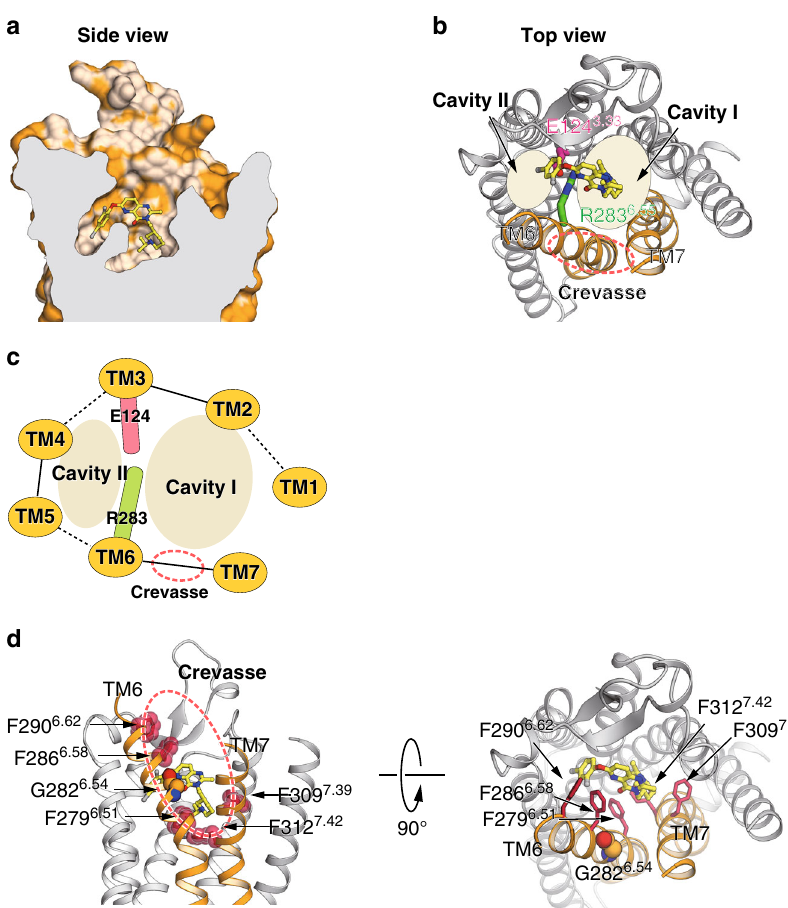
Fig. 2 Bifurcated ligand-binding pocket in the ghrelin receptor, and the structure of the gap. a The cutaway surface for the ghrelin receptor in complex with the antagonist Compound 21 reveals a bifurcated ligand-binding pocket. b The ligand-binding pocket of the ghrelin receptor. c Schematic model of Fig. 2b. d The phenylalanine cluster forms a crevasse in the ghrelin receptor. The fi ve phenylalanines are shown as sticks in dark orange. The crevasse is shown as a red dashed line. G282 is shown as spheres with carbon atoms in orange, nitrogen in blue, and oxygen in